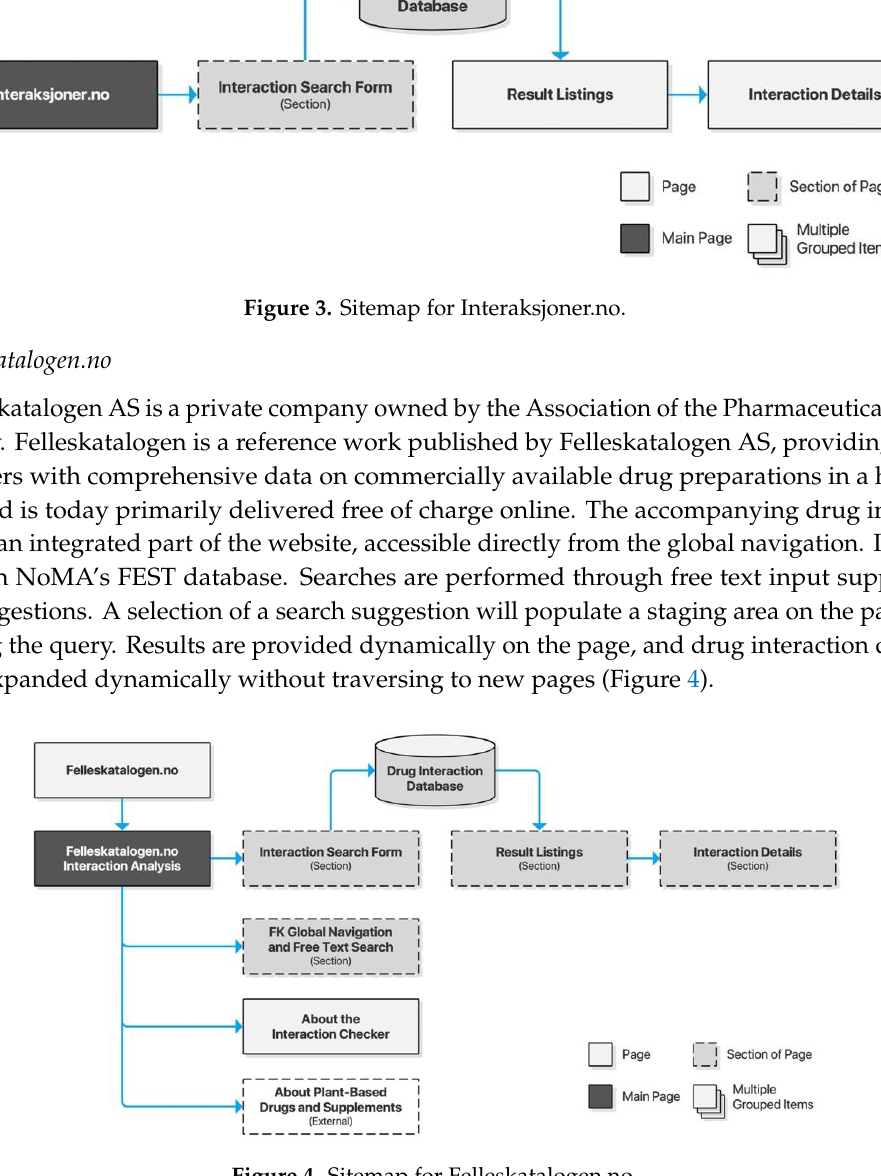
Figure 4. Sitemap for Felleskatalogen.no.